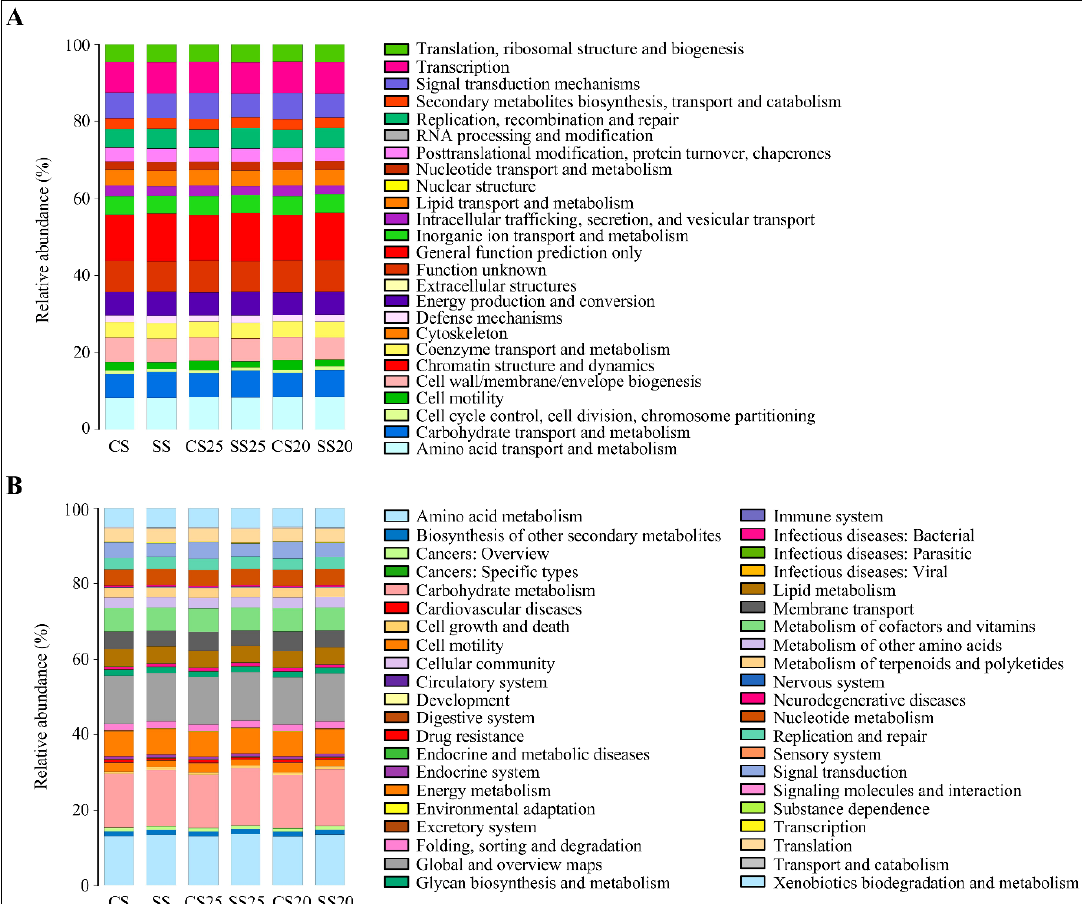
Figure 6. Metabolic functional features of the peanut spermosphere bacterial community. ( A ) Bar chart showing the relative abundance and diversity of functional groups in various peanut spermosphere soil groups and bulk soil groups in the context of the Cluster of Orthologous Groups (COG) database. Different COG groups are displayed in different colors, as listed in the right. ( B ) The Kyoto Encyclopedia of Genes and Genomes (KEGG) database showing the relative abundance and diversity of functional groups in various peanut spermosphere soil groups and bulk soil groups.